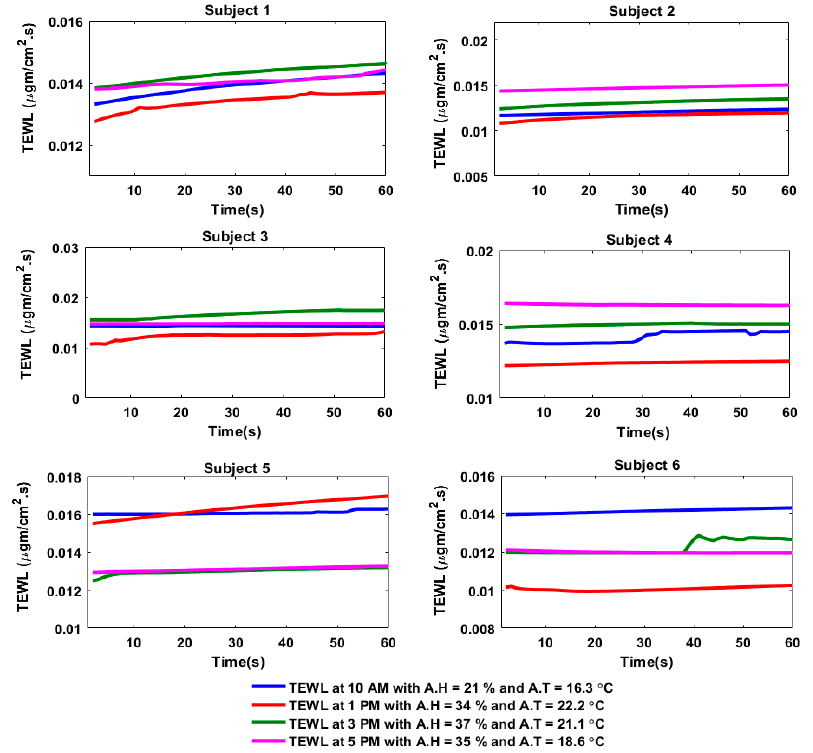
Figure 8. TEWL of the six subjects at different times of the day during the outdoor experiment.